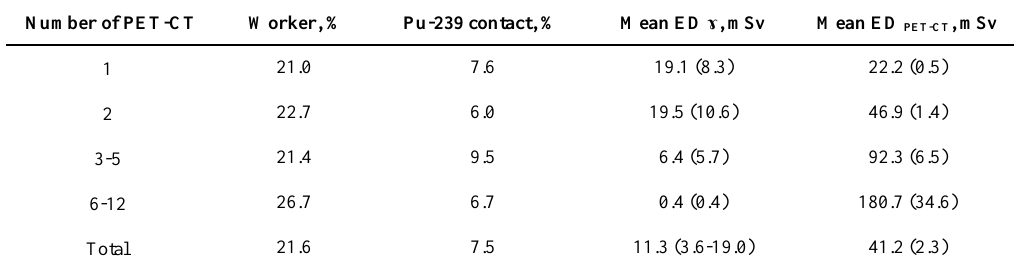
Table 3. Cumulative effective dose (ED) from occupational exposure (ɤ) and PET-CT procedures